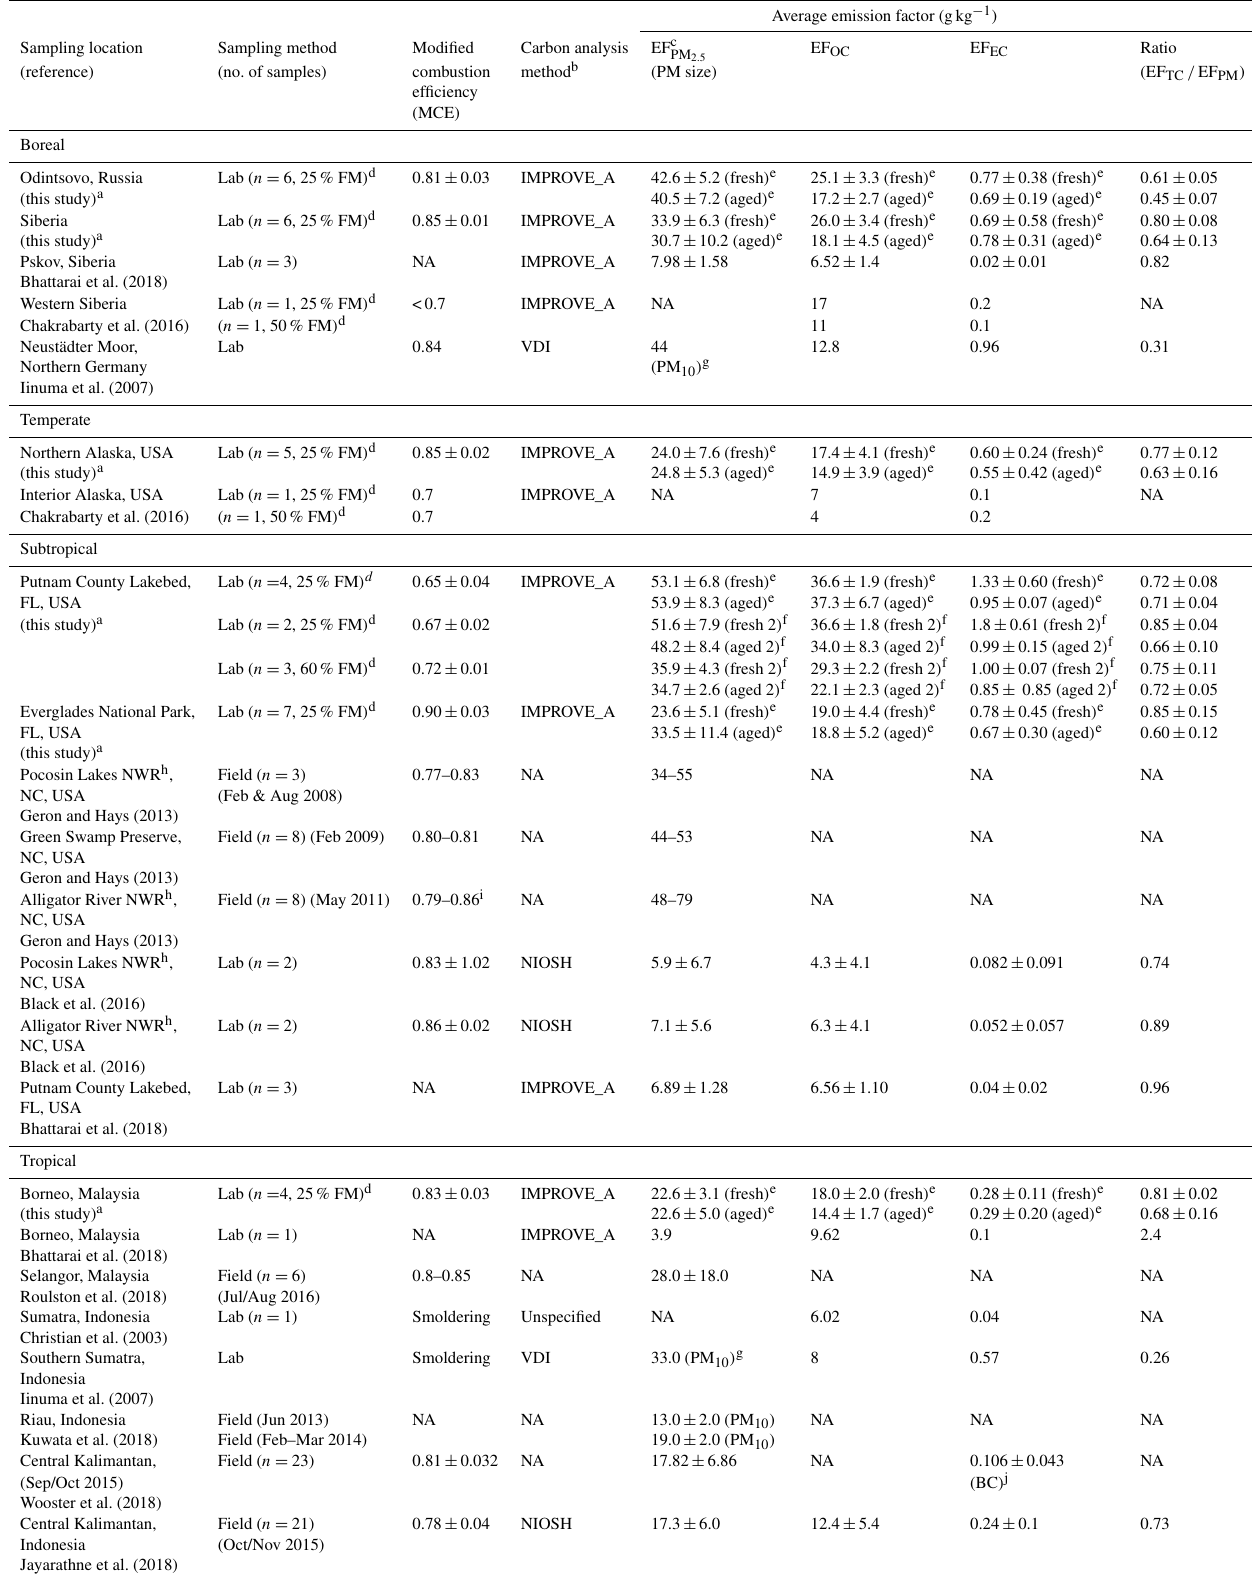
Table 4. Peat combustion emission factors (EFs) for PM 2 . 5 mass and carbon a